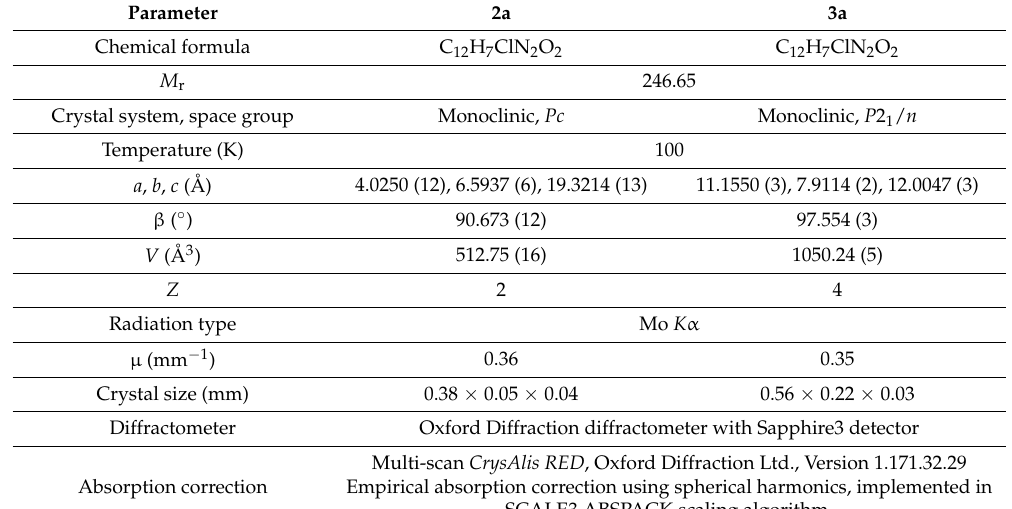
Table 1. Crystal parameters, data collection and refinement details for compounds 2a and 3a .